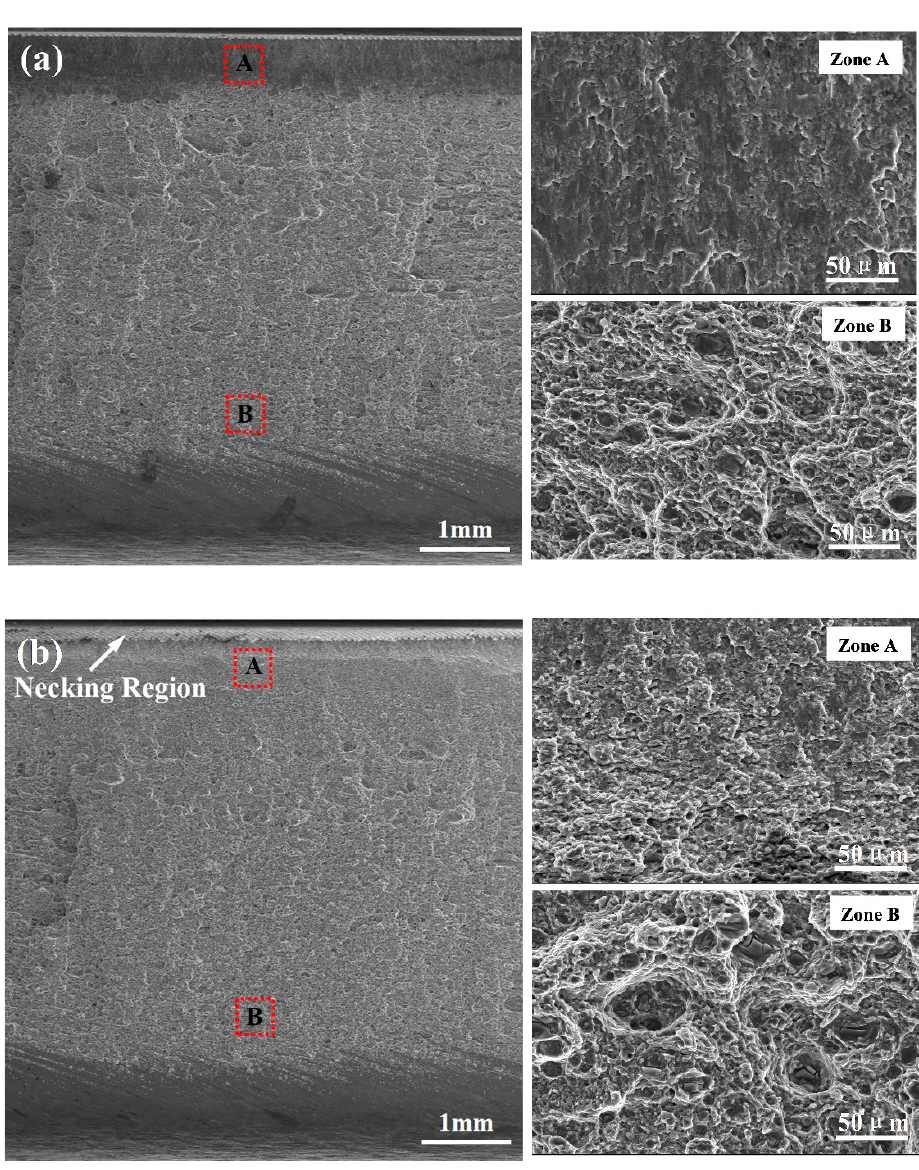
Figure15. FracturemorphologiesoftheFSLWandUAFSLWjointsweldedbytoolT2inlapconfiguration Figure 15. Fracture morphologies of the FSLW and UAFSLW joints welded by tool T2 in lap B: ( a ) FSLW and ( b ) configuration B: ( a ) FSLW and ( b ) UAFSLW.